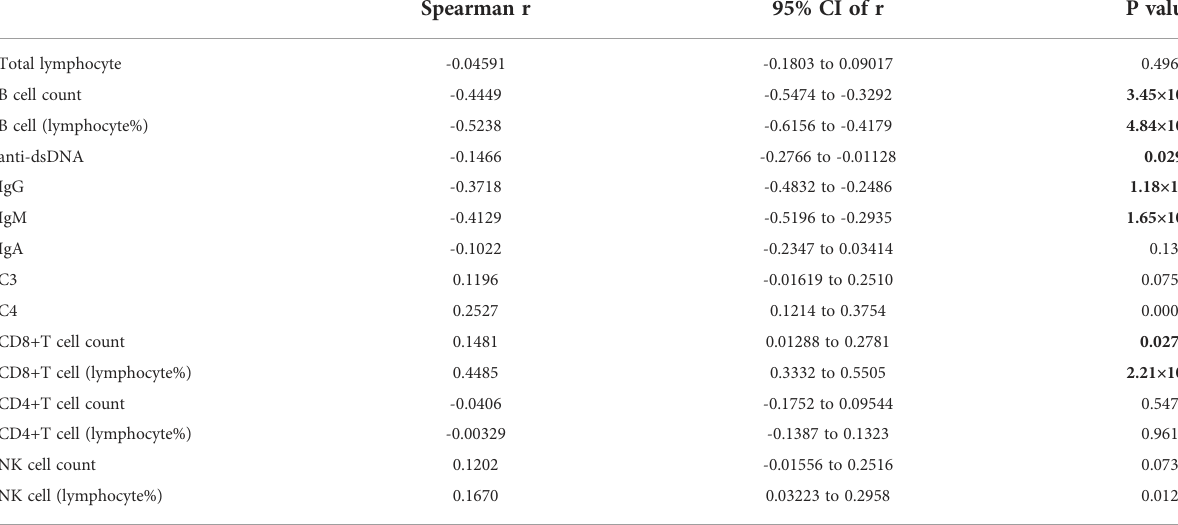
TABLE 2 The correlation of disease duration with immune parameters